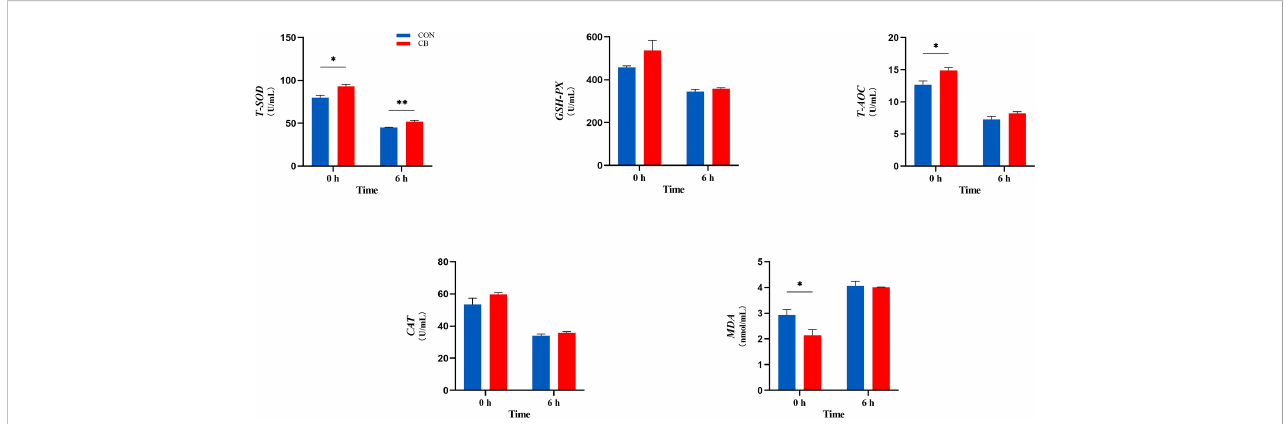
FIGURE 4 Supplement of C. butyricum affected the antioxidant capacity of goat after LPS challenge at 0 h and 6 h. (A) Relevant indicators of plasma antioxidant capacity: T-SOD, total superoxide dismutase; GSH-Px, glutathione peroxidase; T-AOC, total antioxidant capacity; CAT, catalase; MDA, malondialdehyde. * P < 0.05 and ** P < 0.01 between